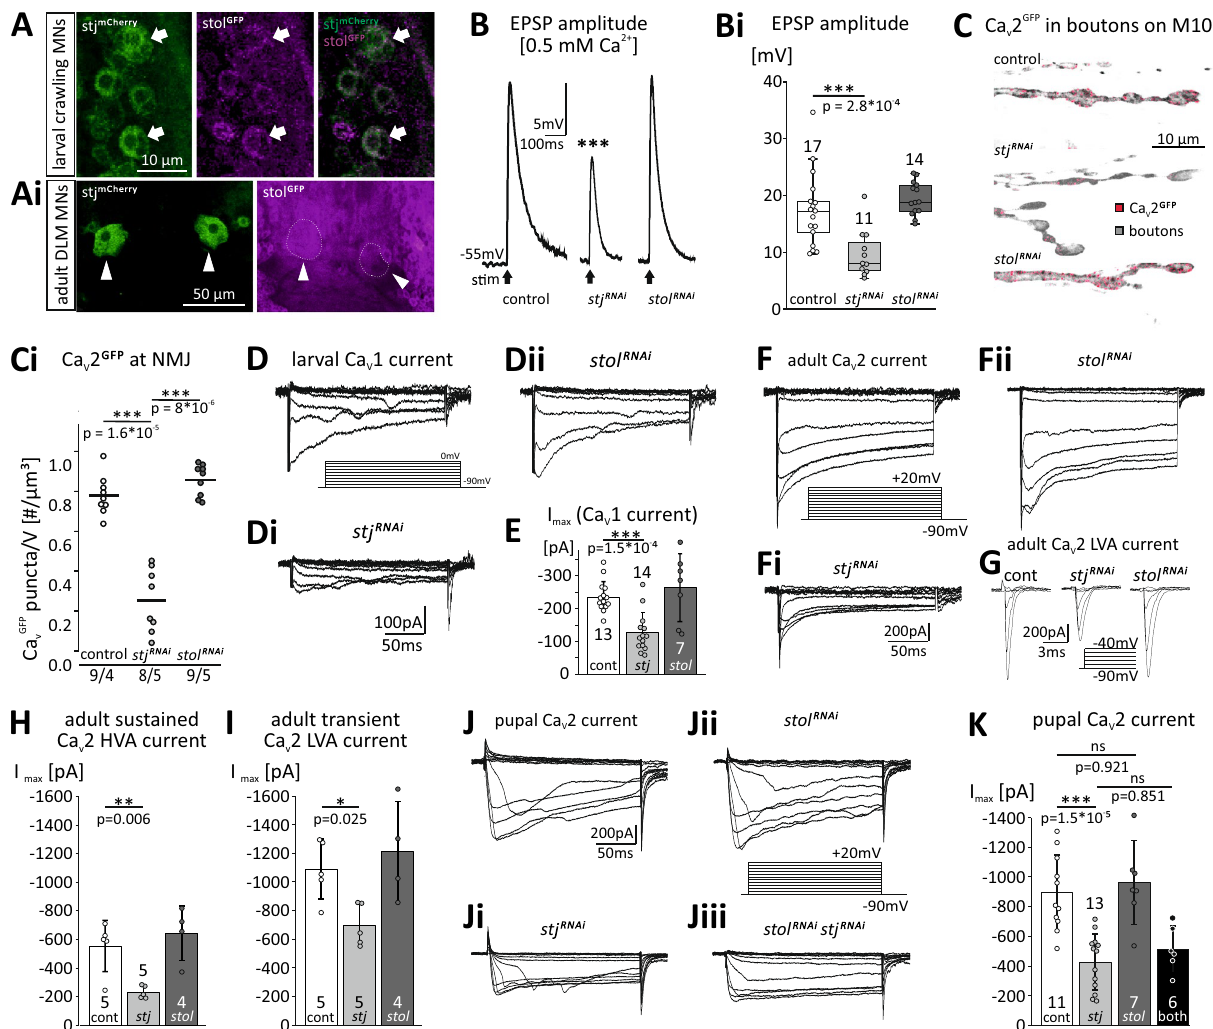
Figure 2. stj but not stol is required for normal MN Ca v 1- and Ca v 2-like current amplitudes. Larval (A) and adult (Ai) Drosophila MN somata show expression of endogenously tagged stol GFP (magenta) and stj mCherry (green). (B, Bi) Compared to control (left trace; white box, n = 17) stj RNAi (middle trace, light gray box, n = 11) but not stol RNAi (right trace, dark gray box, n = 14) reduces muscle EPSP amplitude in response to MN stimulation (*** p < 0.001, Kruskal Wallis ANOVA, Dunn’s post-hoc test). (C, Ci) MN axon terminal boutons on larval muscle 10 contain stj mCherry puncta ( C , top), which are depleted by stj RNAi (middle), but not by stol RNAi (bottom). (Ci) stj mCherry labeling intensity is significantly reduced by stj RNAi (light gray, *** p > 0.001) but not by stol RNAi (dark gray, p = 0.21). (D–E) Larval MN Ca v 1 current ( D, control, 200 ms command voltage steps in 10 mV increments from − 90 to 0 mV) is reduced by stj RNAi (Di) , but not by stol RNAi (Dii) . Quantification (E) reveals 46% amplitude reduction with stj RNAi (n = 14; *** p = 1.5*10 −4 , one-way ANOVA, LSD post-hoc test) but not by stol RNAi (n = 7) as compared to control (n = 13). (F–I) Adult MN5 HVA and LVA calcium currents mediated by the Drosophila Ca v 2 homolog cacophony. (F) Control HVA current (200 ms steps from − 90 mV to + 20 mV in 10 mV increments) is reduced by stj RNAi (Fi) , but not by stol RNAi (Fii) . (G) Control LVA current (left, steps from − 90 mV to − 40 mV) is reduced by stj RNAi (middle) but not by stol RNAi (right). (H–I) Quantification shows ~ 60% reduction of HVA current amplitude (H) by stj RNAi (n = 5, ** p = 0.006, one- way ANOVA, LSD post-hoc test), but not by stol RNAi (n = 4) and 36% reduction of LVA current (I) by stj RNAi (* p = 0.025, one-way ANOVA, LSD post-hoc test) but not by stol RNAi . (J–K) Pupal MN5 Ca v 2 current ( J; K white bar, n = 11) is 53% smaller following stj RNAi ( Ji; K light gray bar, n = 13; *** p = 1.5*10 −5 , one-way ANOVA, Tukey post-hoc test) but unaffected by stol RNAi ( Jii; K , dark gray bar, n = 7). Double stj RNAi stol RNAi did not reduce Ca v 2 current amplitude further than stj RNAi alone ( Jiii, K , black bar, n = 6; p = 0.851, one-way ANOVA, Tukey post-hoc test). Bar diagrams in E–K show means ±